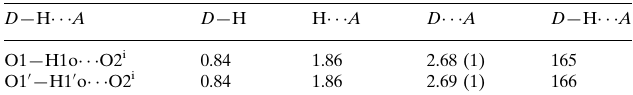
Hydrogen-bond geometry (A˚ , (cid:4)